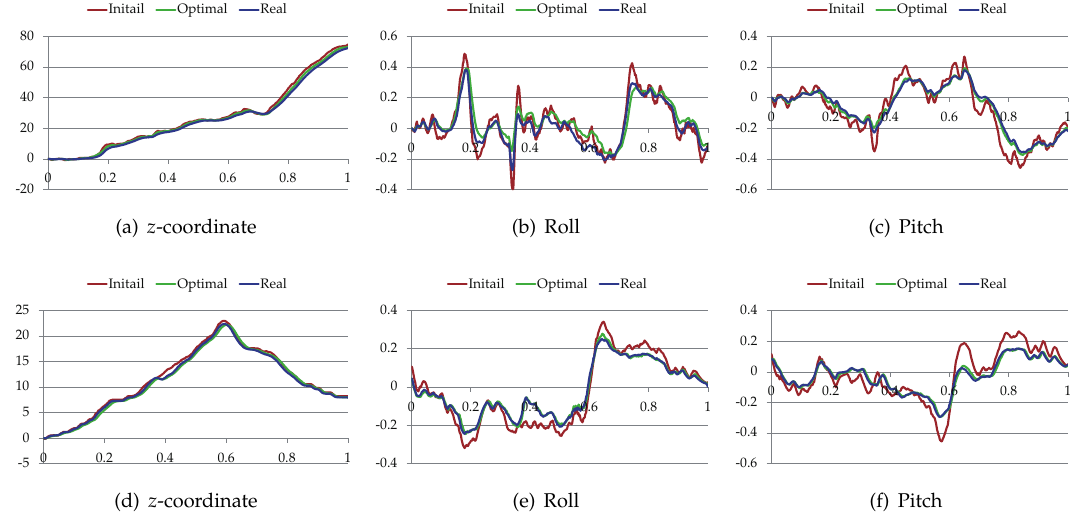
Figure 14. The z -coordinate, the roll and the pitch of the vehicle along the paths and the trajectories. ( a – c ) The vehicle state along the trajectories shown in Figure 13a; ( d – f ) The vehicle state along the trajectories shown in Figure 13b. Table 4. The performance comparison of the paths and the trajectories shown in Figure 13. Note that the real trajectories were often different between different runs, so the data of the real trajectories were averaged over 50